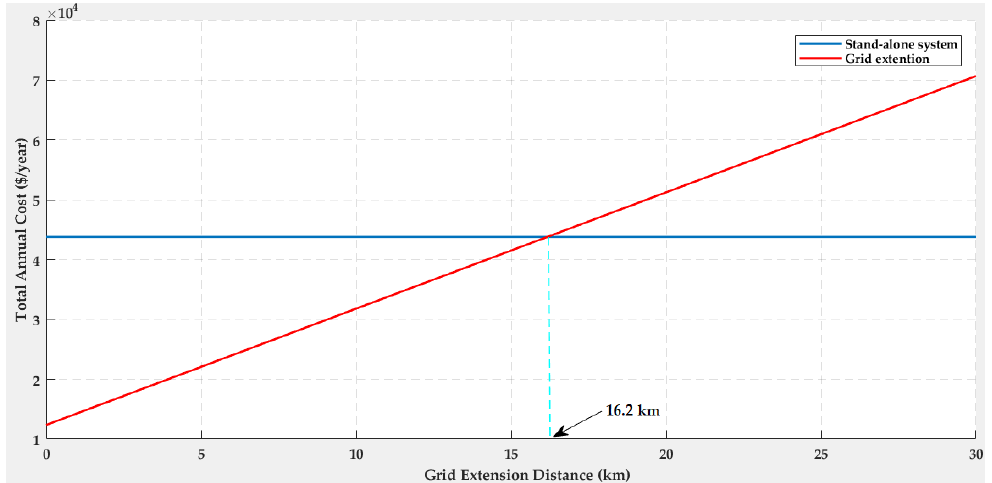
Figure 12. Break-even analysis results for comparing the designed HRES and grid extension.